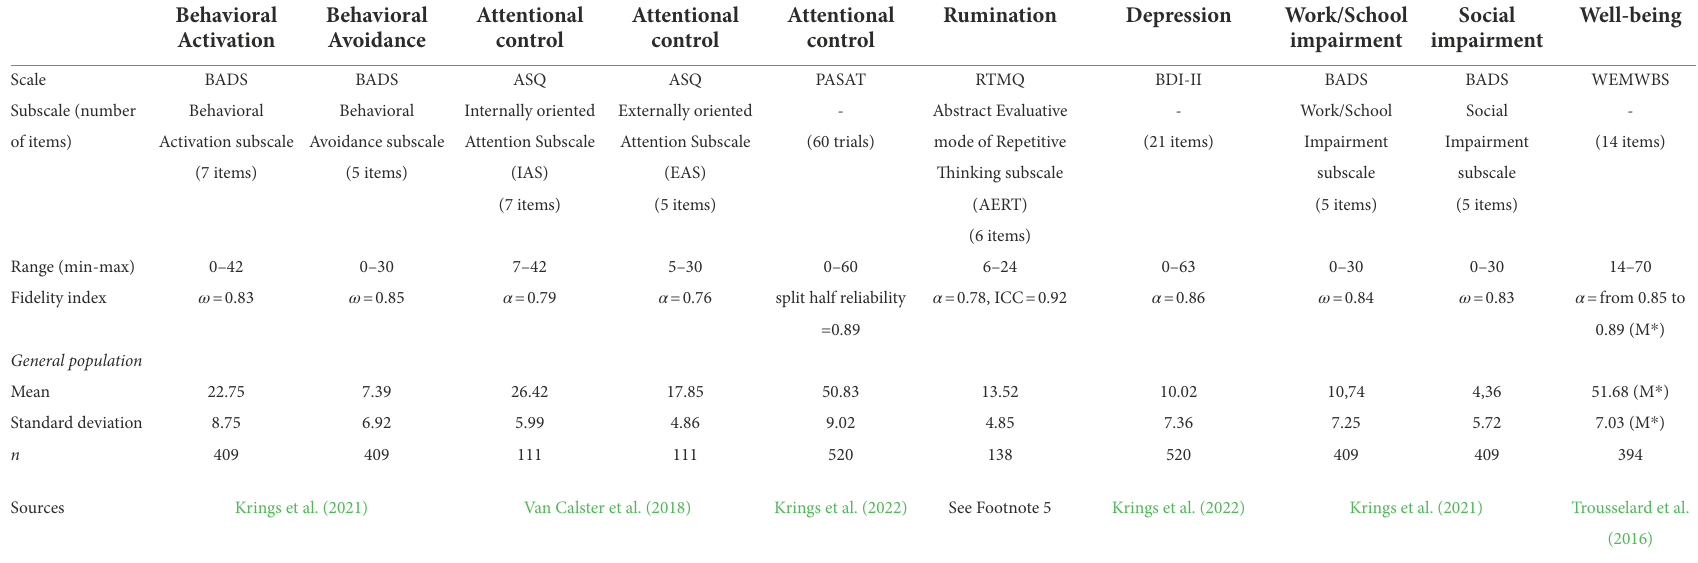
TABLE 2 Fidelity index, mean and standard deviation of standardized subscales. Measures